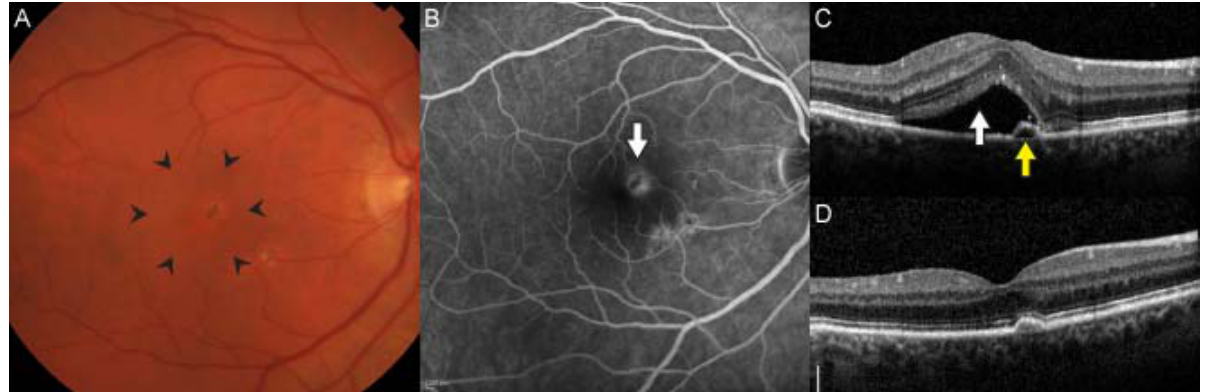
Figure 3. Choroidal neovascularization is the hallmark of neovascular age-related macular degeneration. There is often thickening or elevation of the retina seen clinically through stereoscopic biomicroscopy (area within arrow heads) ( A ); On fluorescein angiography, neovascular membranes appear as hyperfluorescent lesions deep in the retina (arrow) that leak over time ( B ); Spectral-domain optical coherence tomography allows detailed cross-sectional imaging of retinal anatomy. In this patient, there was subretinal fluid (white arrow), and a small adjacent pigment epithelial detachment. Visual acuity was 20/32 ( C ); After 3 monthly intravitreal injections of ranibizumab, the fluid resolved, and visual acuity improved to 20/20 ( D